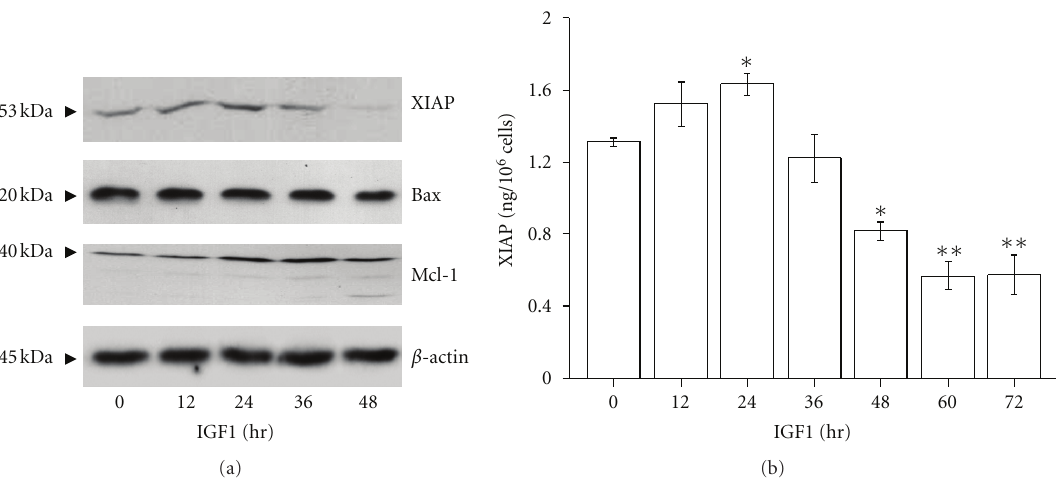
Figure 4: IGF1 has biphasic e ff ects on XIAP protein expression. (a) Western blot assays of VH-64 cell lysates with antibodies to XIAP, Bax, and Mcl-1. Cells were treated for the indicated times with IGF1 (100ng/mL). Representative nonstripped blots separately probed with the di ff erent antibodies are shown. (b) EIA analysis of XIAP in cells incubated for the indicated times with IGF1 (100ng/mL). Asterisks: ∗ P < 0 . 05, ∗∗ P < 0 . 02; error bars: mean ± SD of triplicate determinations from 4 independent